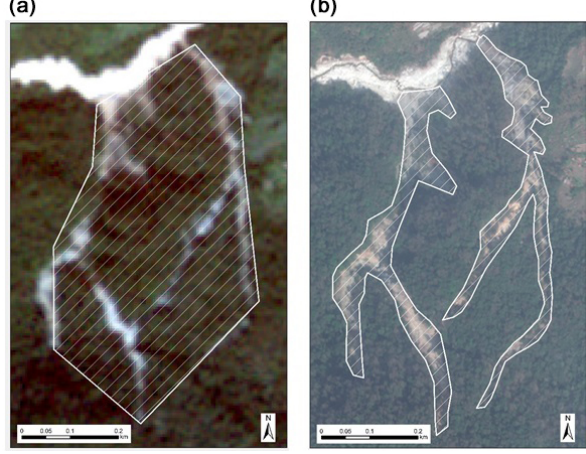
Figure 16. The map on the left shows the lower-resolution image coupled with field survey, and the map on right shows the same area with the detailed mapping in standard GIS. The field survey helped to understand that this is one larger landslide which is covered by vegetation; however office work shows it as two separate landslides and ignored the part of landslide-covered